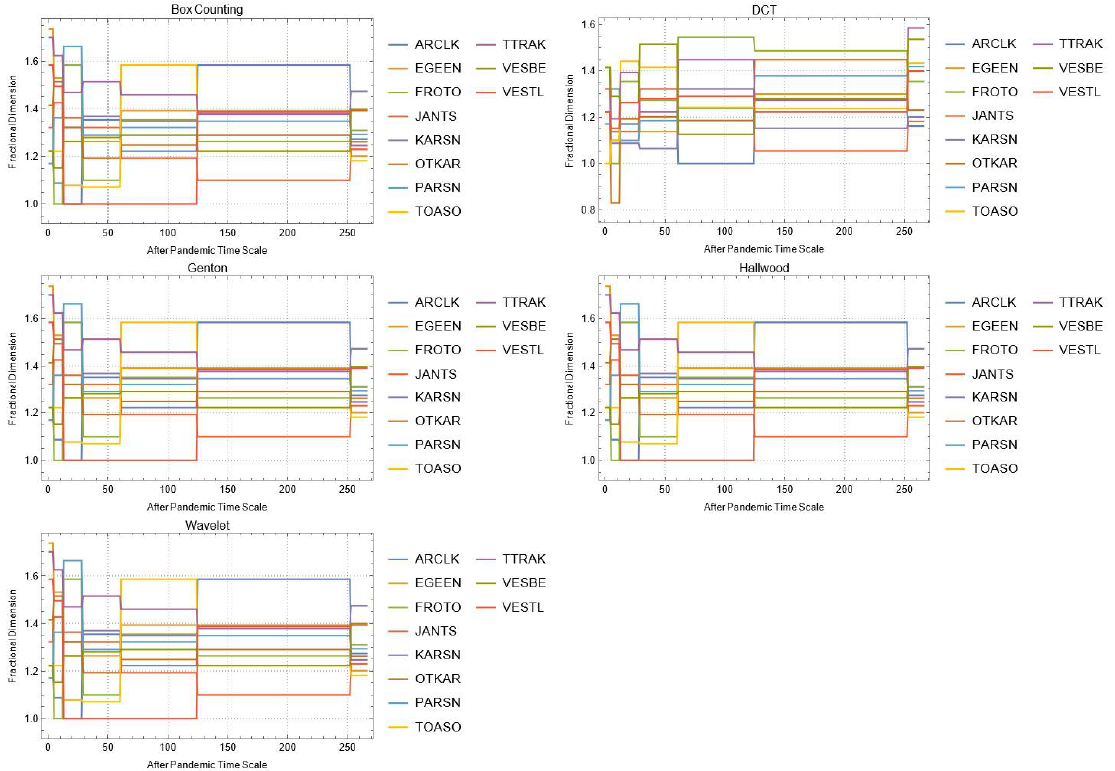
Figure A20. Daily changes of fractal dimensions after the pandemic (chemicals).